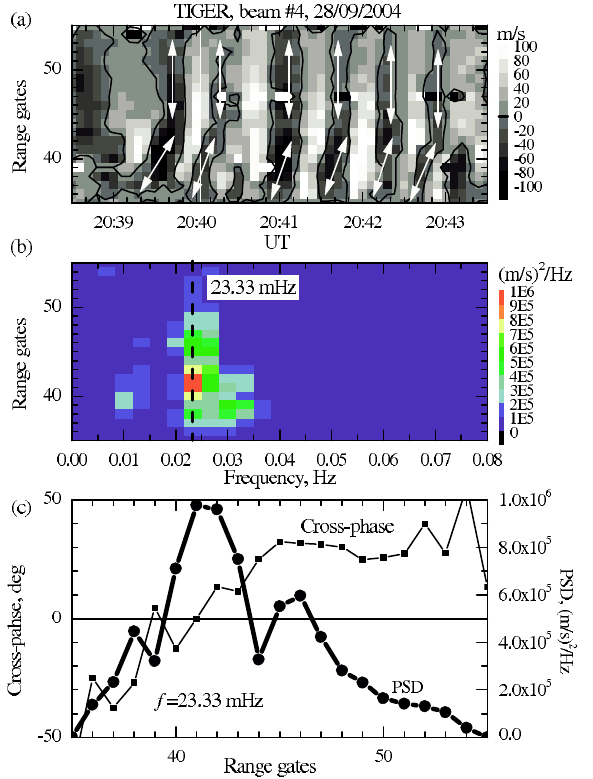
Fig. 5. Example of FLR-like variations in V D over 20:38:30– 20:43:30 UT. (a) Range-time dependence for V D ; white arrows show approximate alignment of the phase front. (b) Power spec- tral density; vertical dashed line corresponds to PSD maximum at 23.3mHz. (c) Latitudinal profile of PSD and cross-phase at 23.3mHz.